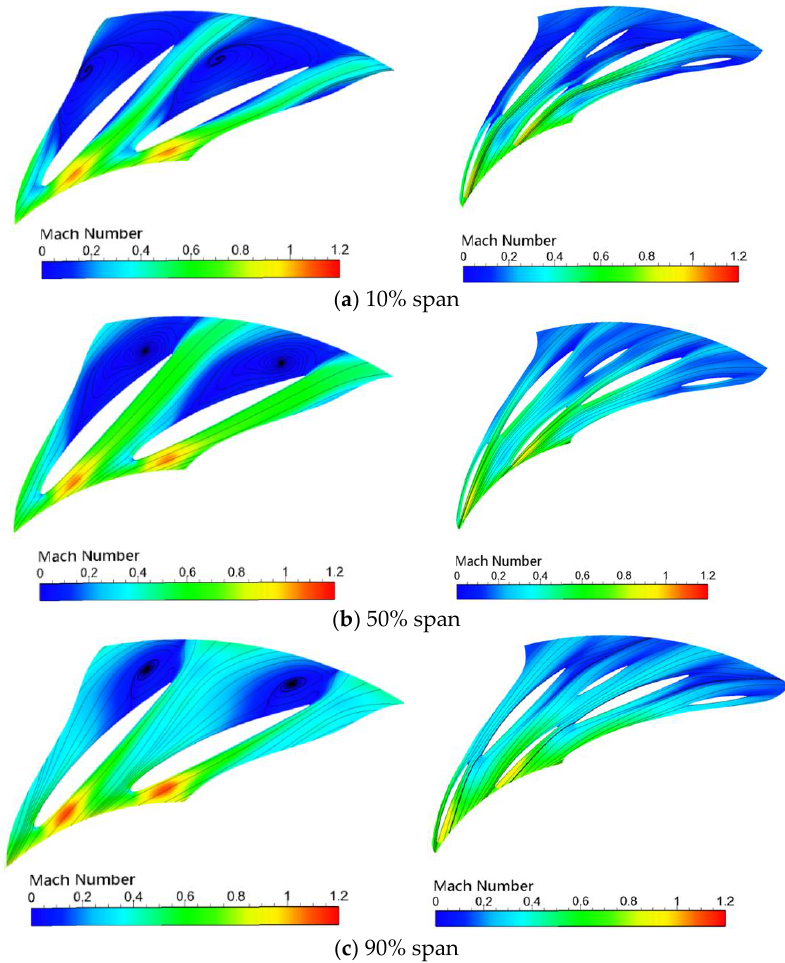
Figure 19. Mach number distribution at different spans of the original and optimized designs of the high-pressure-stage centrifugal compressor at 90% load.